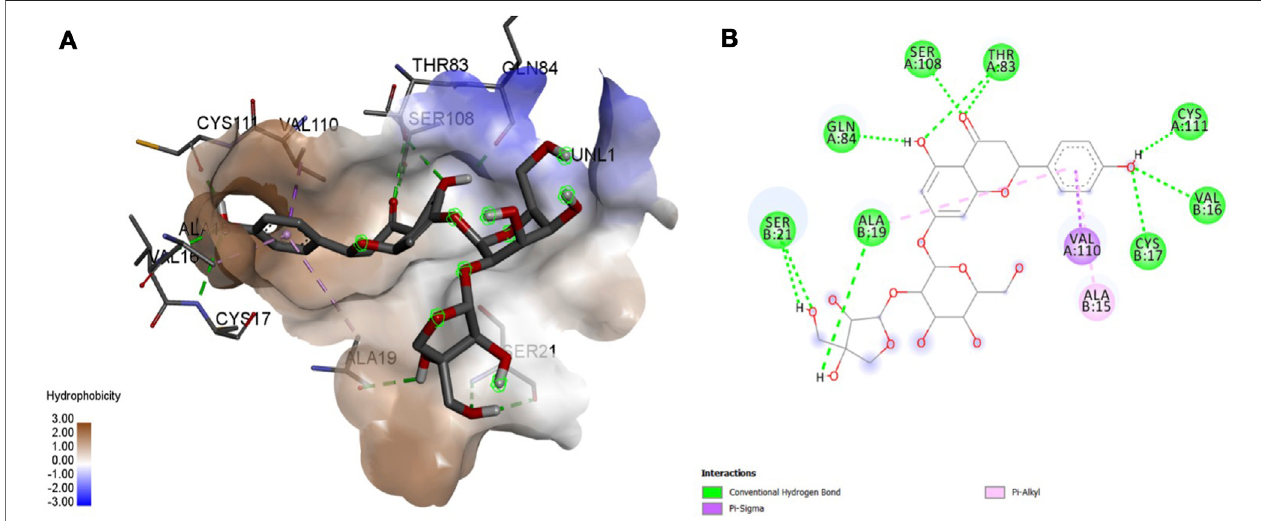
FIGURE 7 | Molecular docking interaction analysis of protein 1B8M, (A) : 3D interactions and (B) : 2D interactions have been represented between 1B8M-Apiin complex structures.